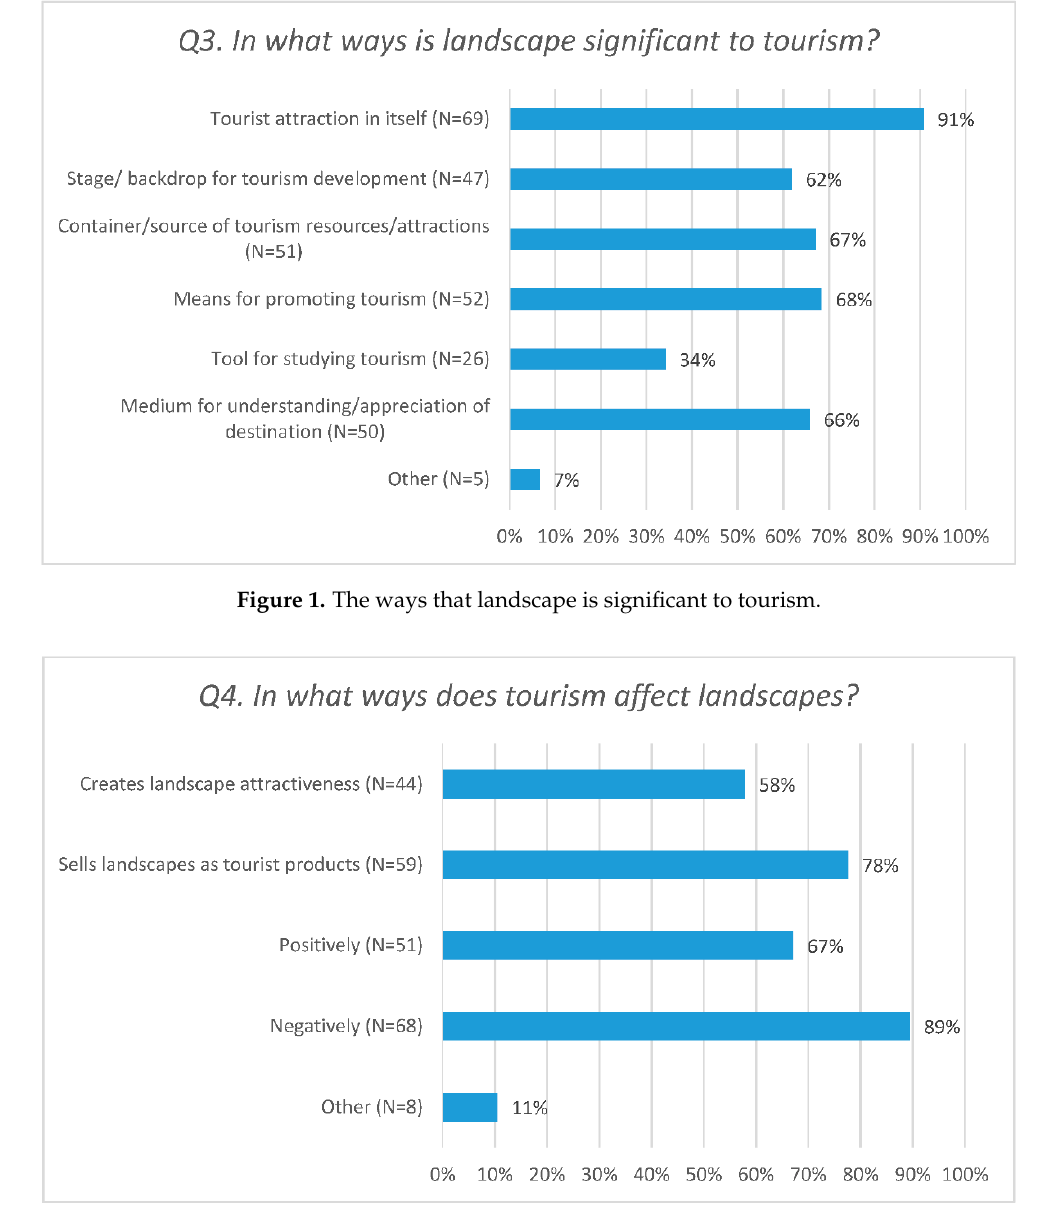
Figure 2. The ways tourism affects landscape